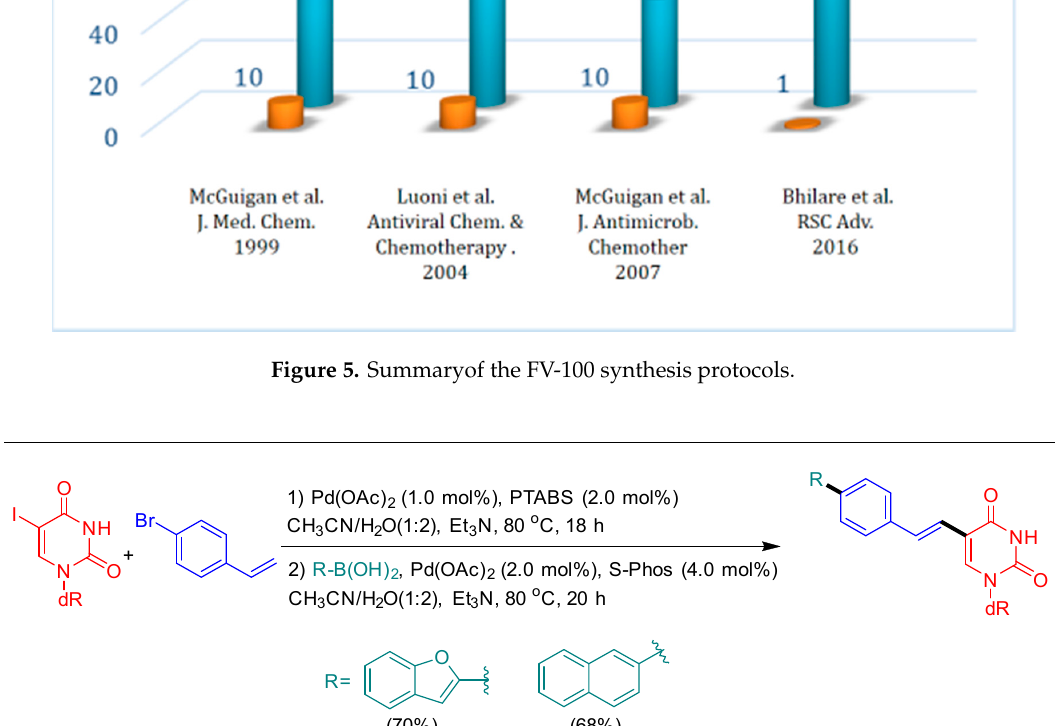
Scheme 11. Tandem one-pot Heck/Suzuki coupling of 5-IdU.